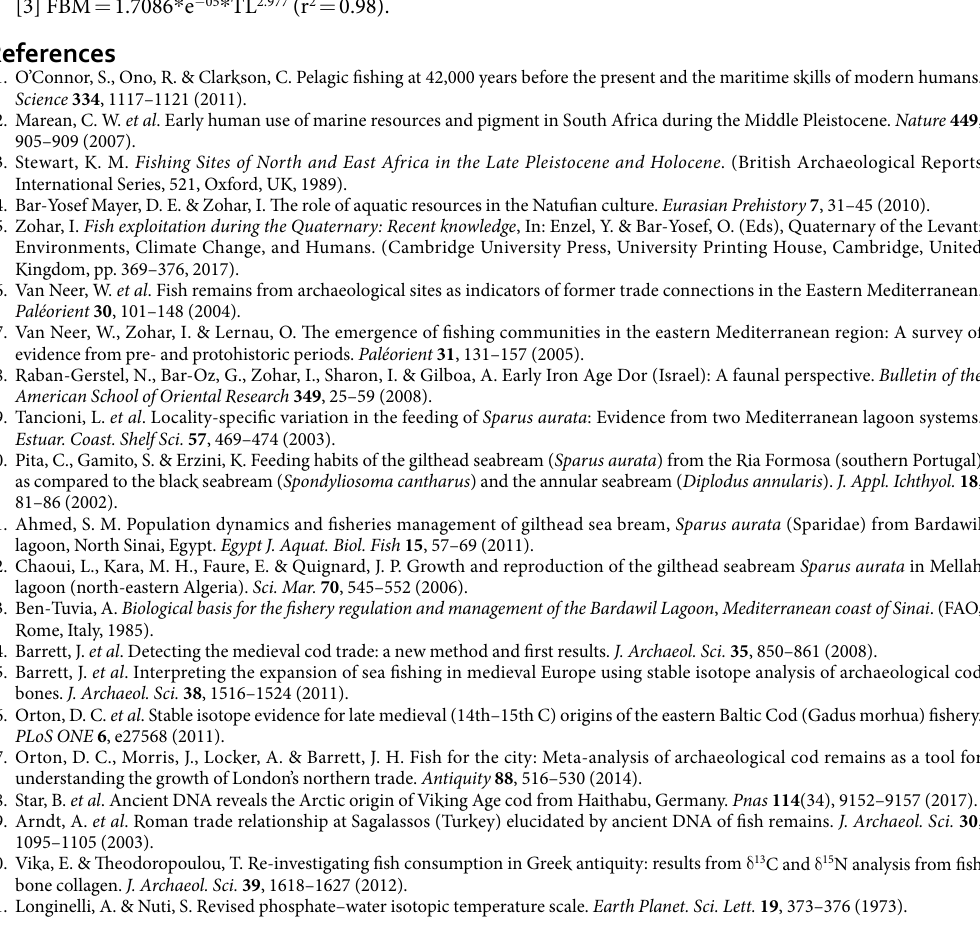
i.e., as the deviation in per mil (‰) relative to Vienna Standard Mean Ocean Water (VSMOW), the international reference material. The δ 18 O PO4 values were measured with an external precision of ± 0.3‰ (1 SD). The raw δ 18 O PO4 values were normalised to an Ag 3 PO 4 standard produced by Elemental Microanalysis with a certified value of 21.7‰ (silver phosphate P/N IVA33802207, batch no. 180097, distributed by IVA Analysentechnik, Germany). The analytical precision for this standard was better than ± 0.3‰ (1 σ ). For untreated NIST SRM 120c Florida phosphate rock standard reference material, we obtained a δ 18 O PO4 value of 21.9 ± 0.3‰ (n = 9). This value compares well with the values around 21.7‰ initially measured by Lécuyer et al . 64 and cur- rently reported by most other laboratories as compiled in Chenery et al . 65 . We calculated the equilibrium range of δ 18 O PO4 in the littoral of the southeast Mediterranean and in hypersaline lagoons, evolving from typical southeast Mediterranean water. The calculation is based on the temperature-dependent relation for isotope fractionation during biomineralisation of apatite by Lécuyer et al . 22 : T °C = 117.4–4.5( δ 18 O PO4 − δ 18 O SeaWater ), where δ 18 O PO4 and δ 18 O SeaWater correspond to the isotope compositions of bio-apatite and seawater relative to VSMOW, respectively. This relation is valid for the temperature range of 8 °C < T < 32 °С relevant for the water temperatures encoun- tered in the Mediterranean realm 37,38 . Body mass of ancient fish can be estimated from species-specific regressions with bone or molariform tooth size. In this study, we used the tooth length measurements recom- mended for the first molariform tooth (Fig. S1), and regression equations to estimated fish total length (cm) and body mass (kg) 48 : Linear regression calculated from S . aurata first molariform tooth maximum length (FMTL) to fish total length (TL). [2] TL = 32.21 * FMTL + 154.07 (r2 = 0.83; Fig.